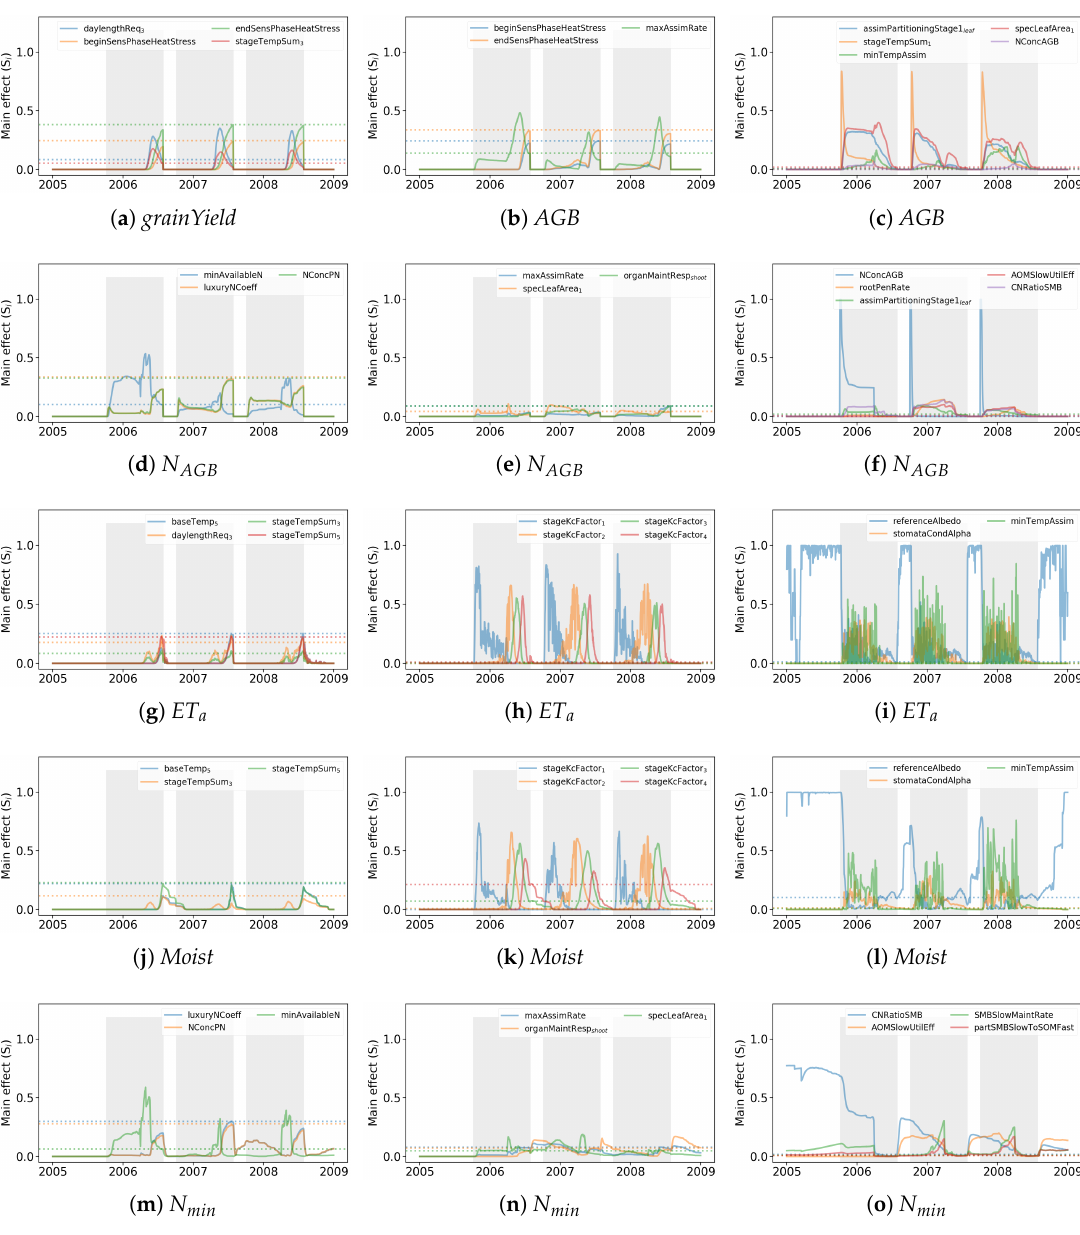
Figure 5. Variations in parameter sensitivities with simulation time for various outputs averaged over all study sites. The solid lines indicate the time-dependent parameter sensitivities based on the main effects (S i ). The dotted lines represent the sensitivity values calculated based on the main effect indicated by the original extended FAST approach at harvest time (Figure 4). The gray shaded ranges correspond to the cultivation period for winter wheat, from sowing in October up through harvest in July (Table 2). Further information can be found in Figures A1–A6 in the Appendix A, which show in detail the time-dependent main effects differentiated for each study